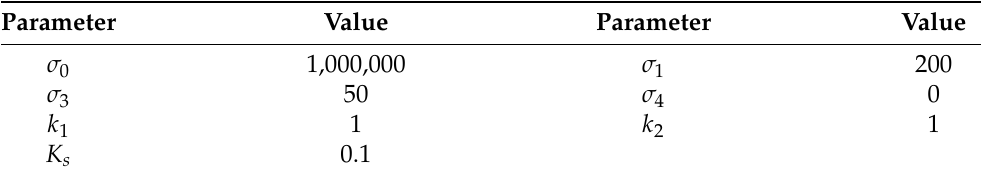
Table 1. Control Parameters used in (9), (10), and (16).